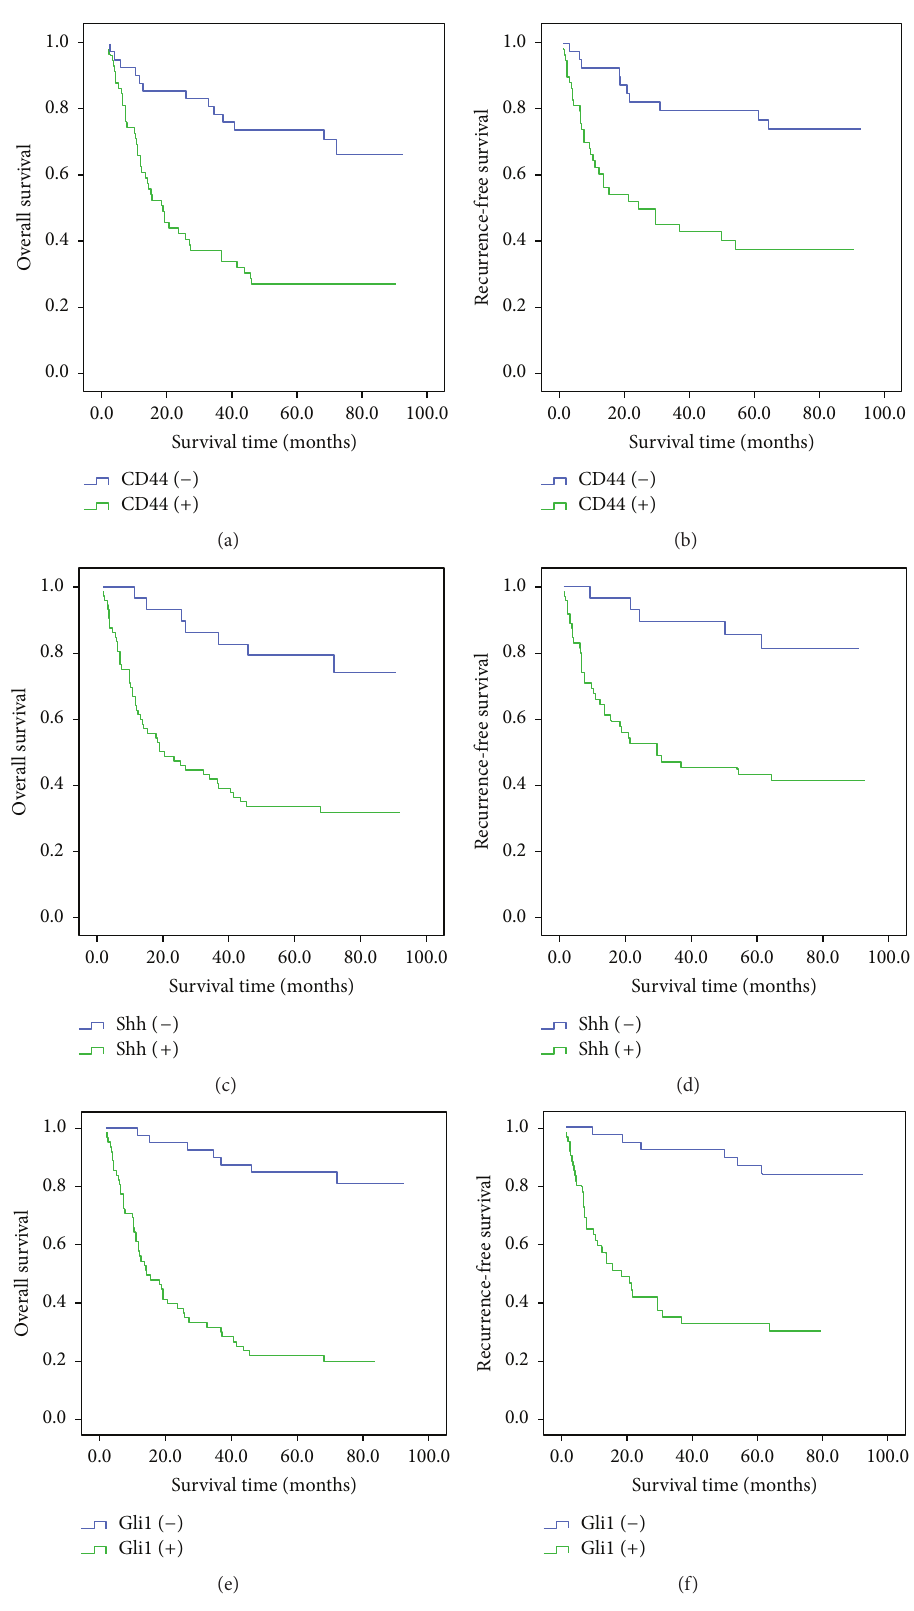
Figure 2: Prognostic impact of CD44, Shh, and Gli1 markers. (a) CD44 and overall survival, (b) CD44 and recurrence-free survival, (c) Shh and overall survival, (d) Shh and recurrence-free survival, (e) Gli1 and overall survival, and (f) Gli1 and recurrence-free